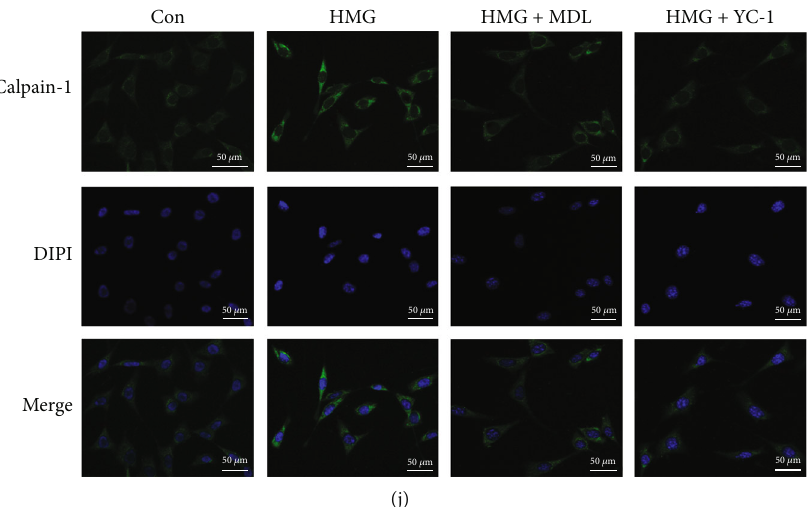
Figure 8: AS-IV inhibits hypoxia-induced activation of the calpain-1/HIF-1 α /caspase-3 pathway in HT22 cells. (a, b) Calpain-1 expression in HT22 cells was observed by immuno fl uorescence ( n = 3 ; F ð 5,12 Þ = 855 : 217 ). (c – e) Western blotting was used to detect calpain-1 and HIF- 1 α protein expression ( n = 3 ; calpain-1, F ð 5,12 Þ = 52 : 836 ; HIF-1 α , F ð 5,12 Þ = 32 : 445 ). (f – h) After YC-1 was introduced, the protein expression of calpain-1 and caspase-3 was detected by Western blotting ( n = 3 ; calpain-1, F ð 3,8 Þ = 180 : 664 ; caspase-3, F ð 3,8 Þ = 148 : 465 ). (i, j) After introducing YC-1, the expression of calpain-1 in HT22 cells was observed by immuno fl uorescence ( n = 3 ; F ð 3,8 Þ = 129 : 190 ). Data are presented as the mean ± SD . ∗∗ P < 0 : 01 compared with the HMG group, # P < 0 : 05 , ## P < 0 : 01 compared with the ASIV 50 μ M